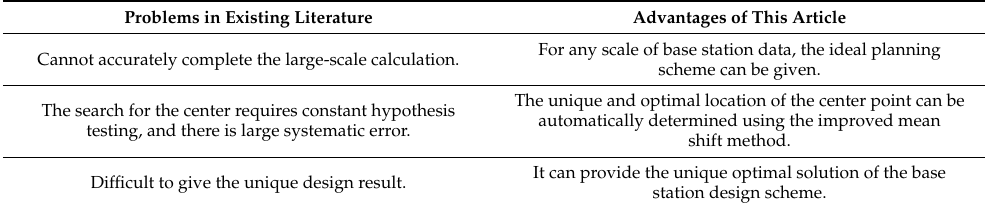
Table 1. Comparison between the methods used in the existing literature and in this